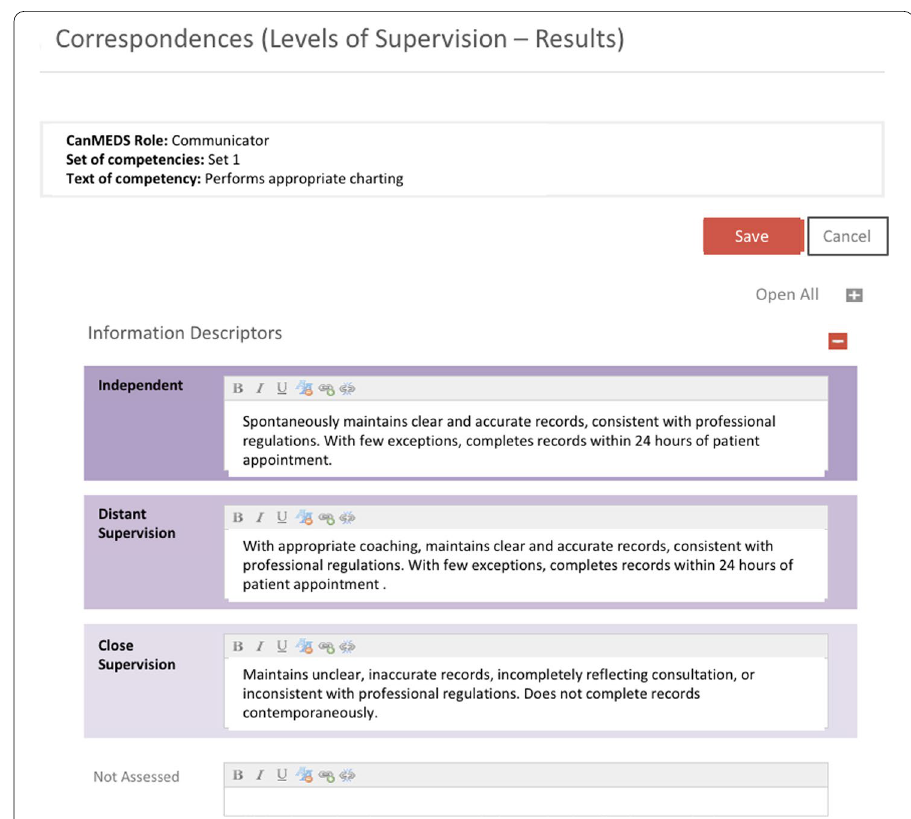
Fig. 8 Competency developmental benchmarks based on the level of